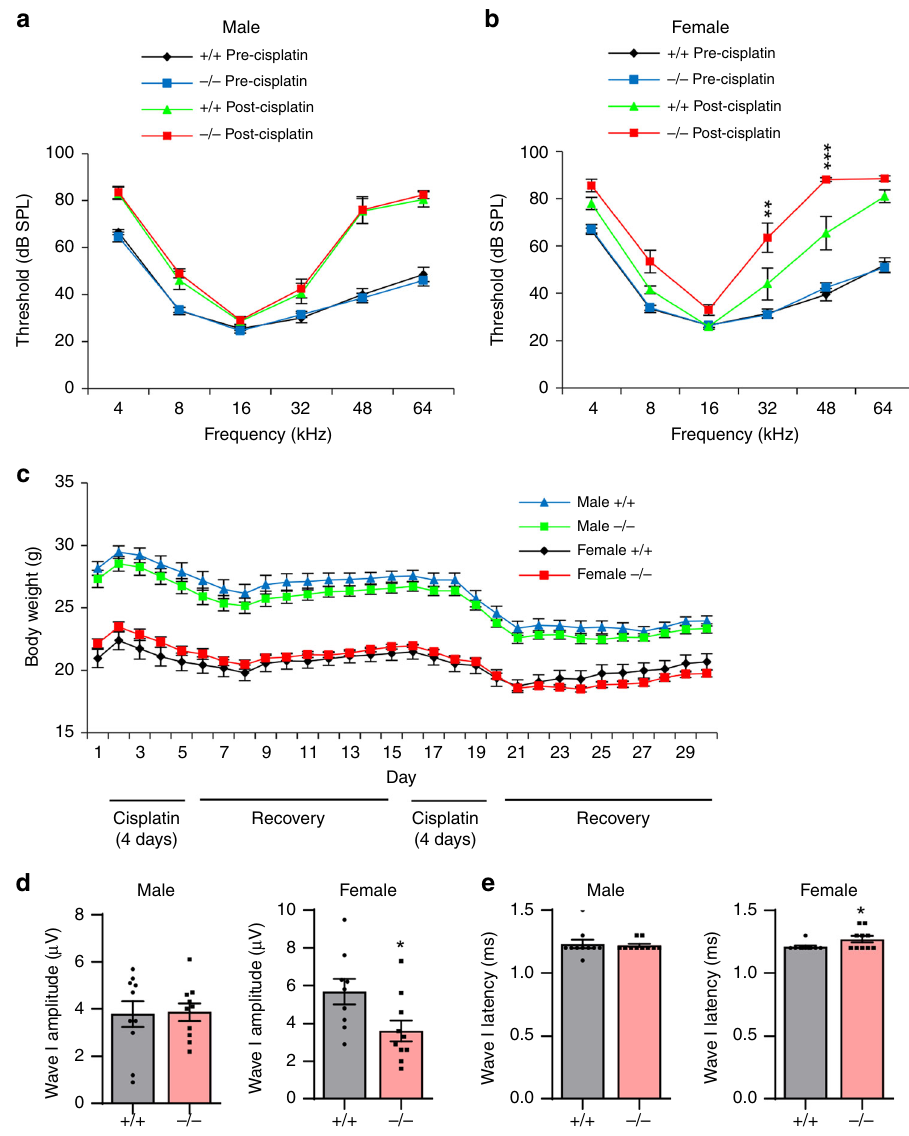
Fig. 2 Assessment of ABR hearing thresholds, wave I amplitudes, and latencies. a , b ABR hearing thresholds were measured at 4, 8, 16, 32, 48, and 64 kHz in male ( a ) and female ( b ) Gsta4 + / + and Gsta4 − / − mice. n = 10, * p < 0.05 vs. + / + post-cisplatin (two-way ANOVA). Error bars represent ± s.e.m. c The body weight of male and female Gsta4 + / + and Gsta4 − / − mice was measured during cisplatin treatment. n = 10. Error bars represent ± s.e.m. d , e ABR wave I amplitudes ( d ) and latencies ( e ) were measured in male and female Gsta4 + / + and Gsta4 − / − mice. n = 10, * p < 0.05 vs. + / + (unpaired two-tailed Student ’ s t test). Error bars represent ± s.e.m. Source data are provided as a Source Data fi